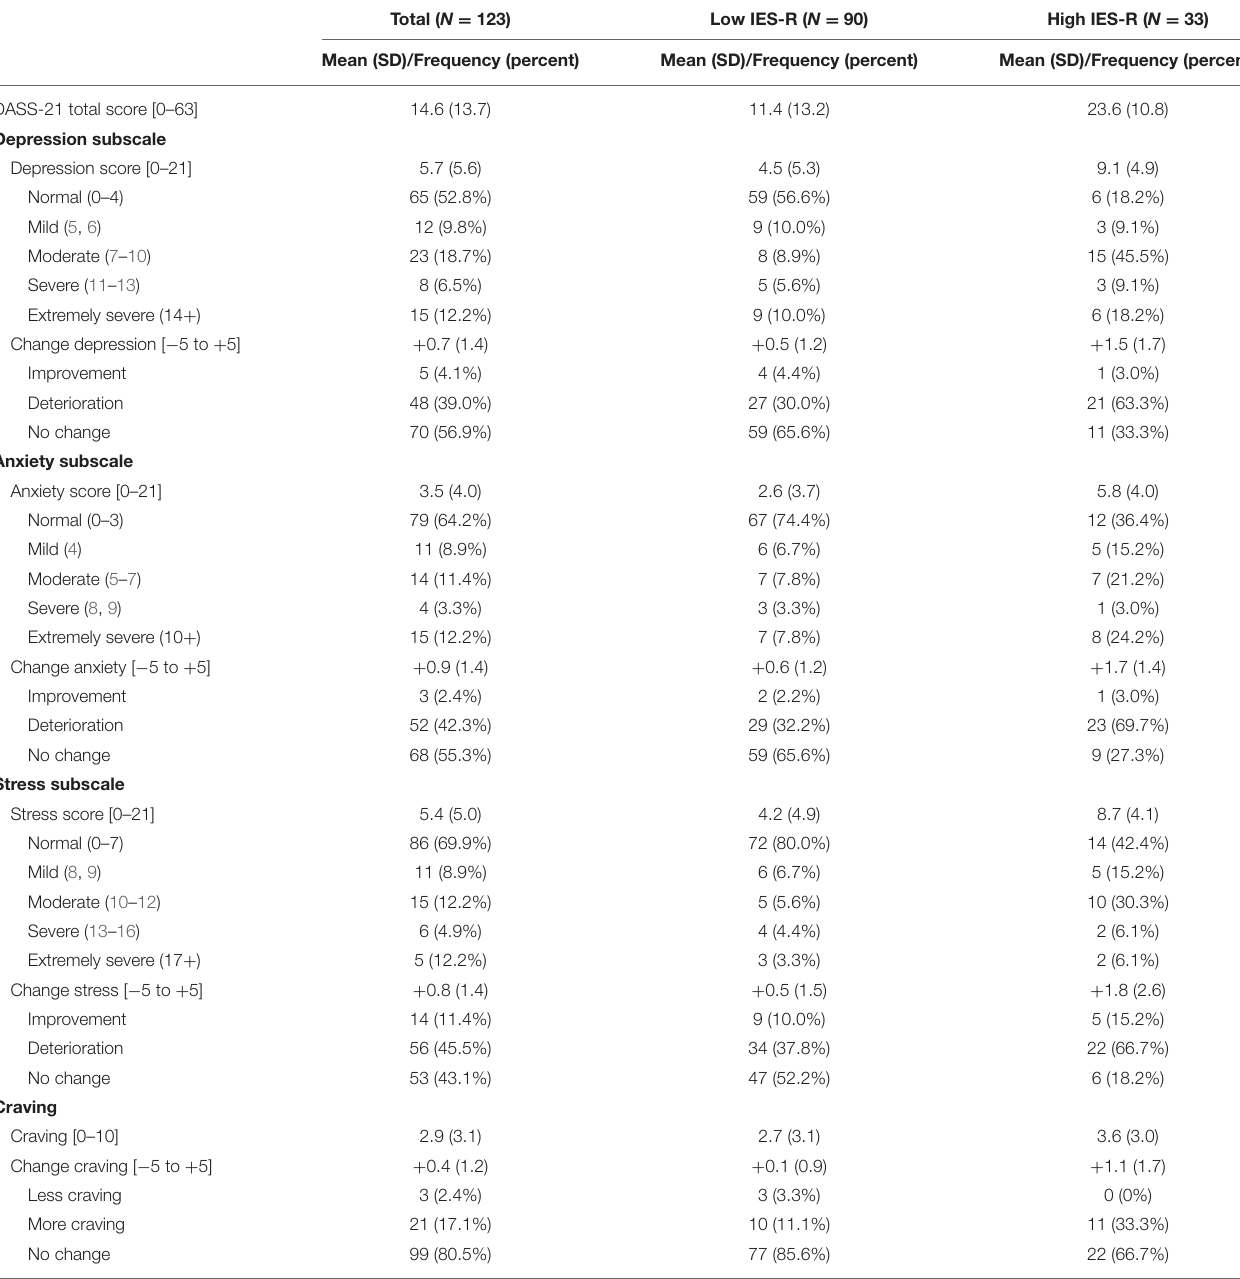
TABLE 3 | Descriptive statistics, severity levels, and COVID-19-related changes on the three subscales of the DASS-21, and for craving, displayed for the total sample and the two subgroups,